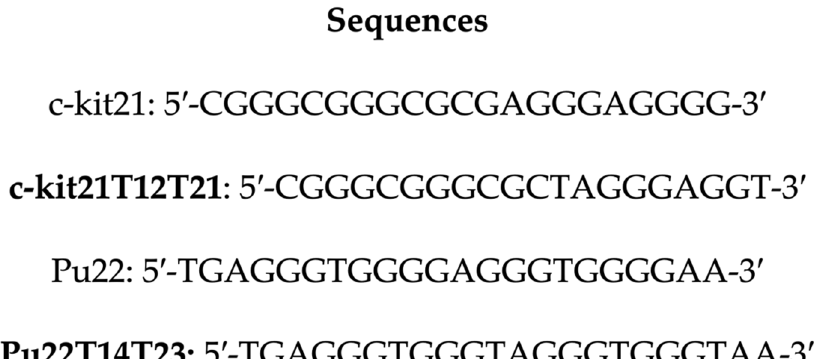
Scheme 1. Schematic representation of the nucleotidic sequences in c ‐ kit21 and Pu22 and their mu ‐ tated counterparts.